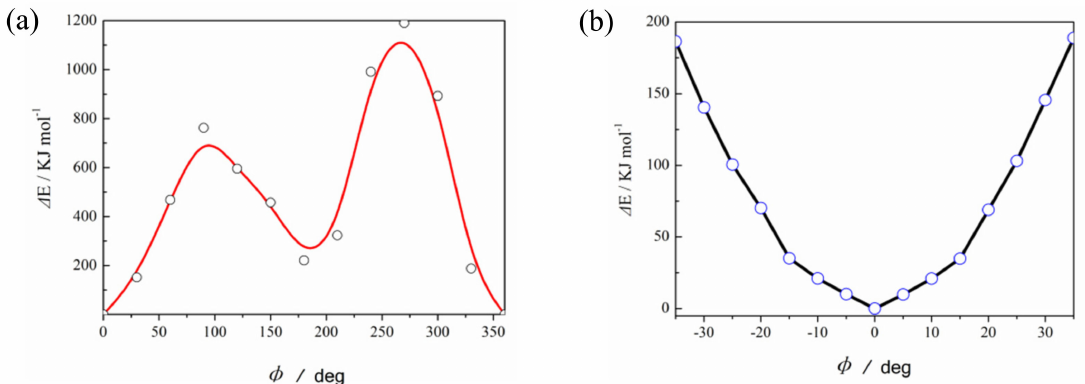
Figure 5. Potential energy curves for ( a ) rotational motion of the phenyl ring of the 3-nitroanilinium cation along its C –N bond and ( b ) pendulum-like motion of the nitro groupin the range of − 35 ◦ to 35 ◦